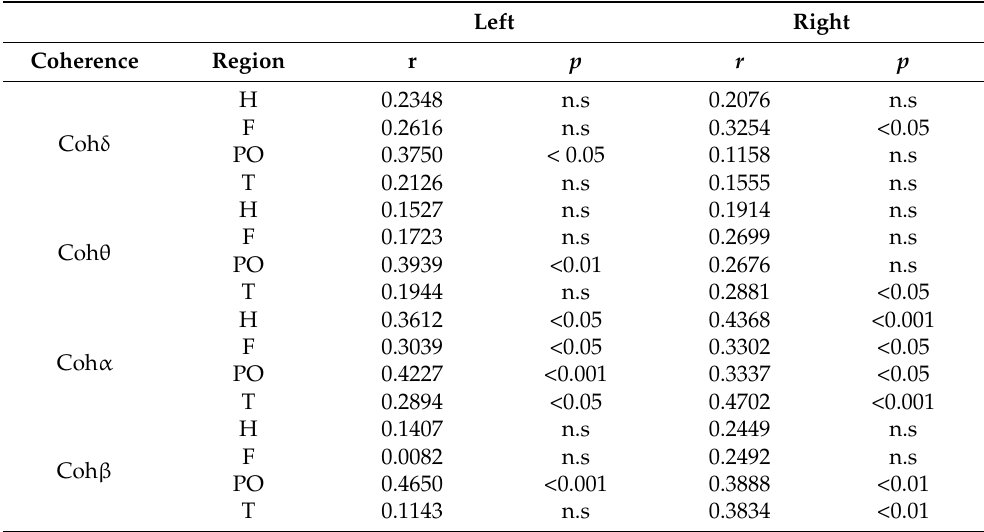
Table A1. Numerical values for correlation coefficients and the significance (Student’s t -test) for the coherence measures ( N = 37).